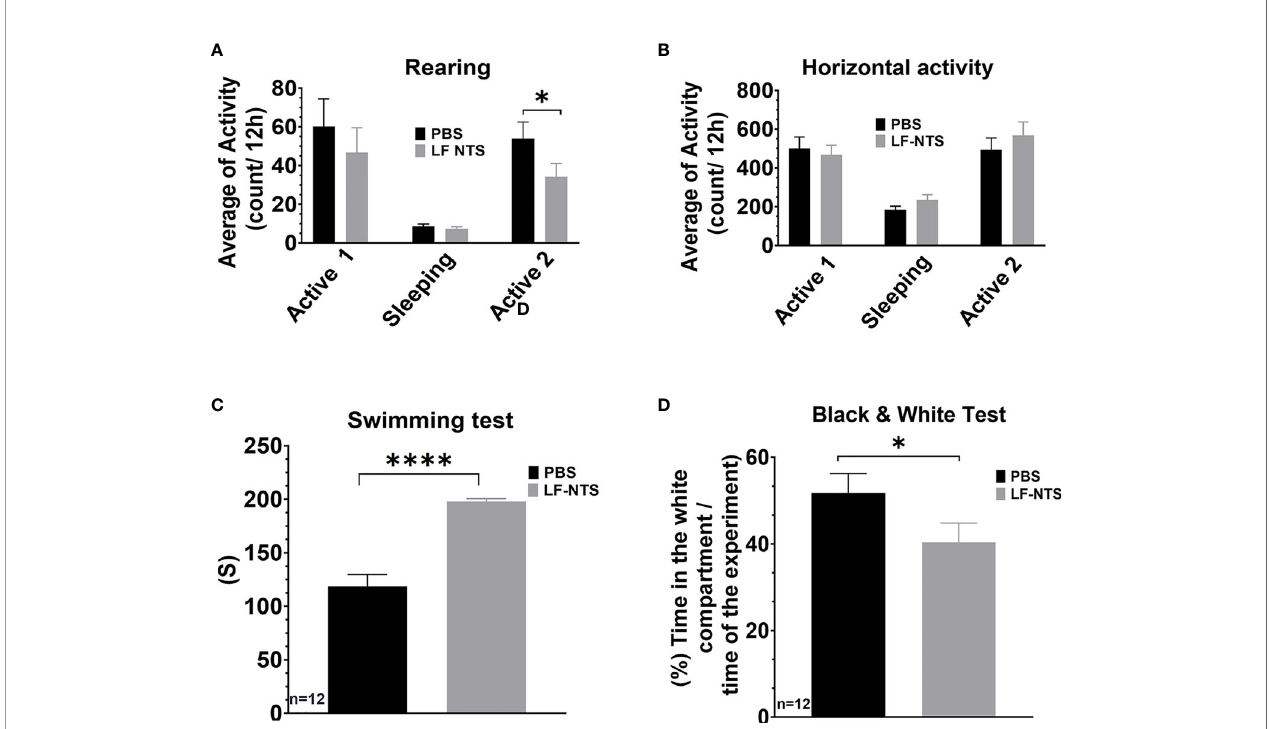
FIGURE 7 | Behavioral tests upon FL-NTS polypeptide treatment. 12 Mice were treated with puri fi ed LF NTS three times a week with PBS or LF NTS polypeptide for 2 to 4 weeks. (A) Rearing preformed over 48h; the calculation was performed during the 2 active phases (8pm to 8am) and a sleeping phase (8am to 8pm). (B) Horizontal activity. (C) Swimming test. (D) Black and white test. t test. *p < 0.05; ****p <